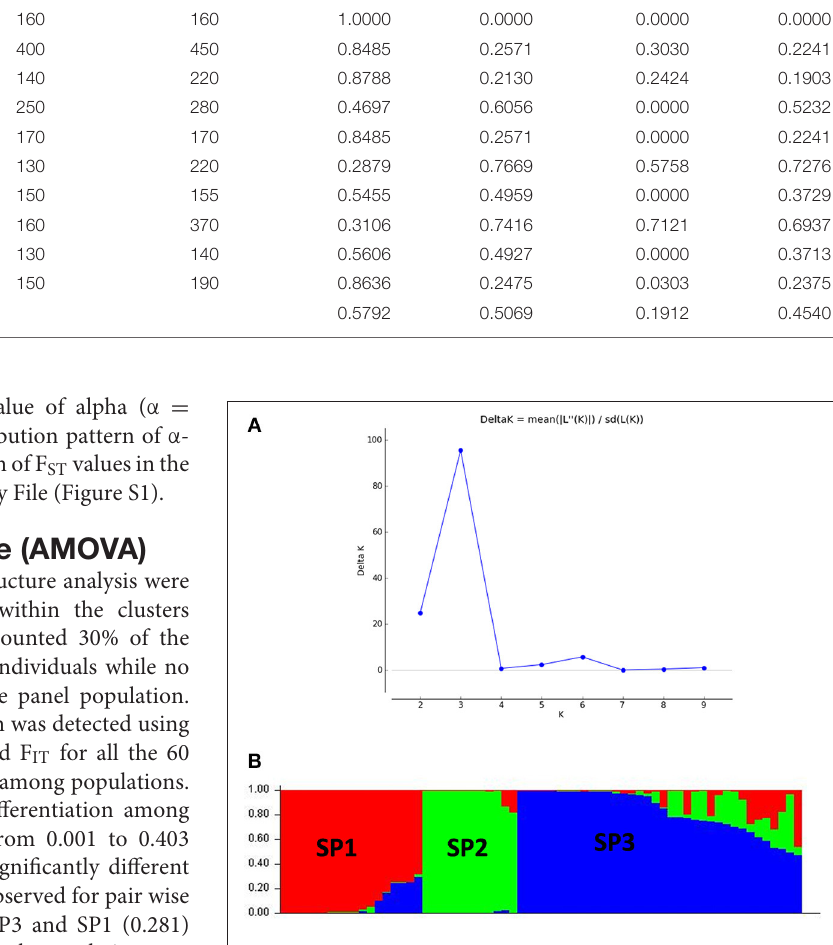
FIGURE 5 | (A) Graph of estimated membership probability fraction for K = 3. The maximum of ad-hoc measure 1 K determined by structure harvester was found to be K = 3, which suggested that the entire population can be categorized into three sub-groups (SP1, SP2, and SP3) and (B) population structure of a panel possessing 66 genotypes based inferred ancestry using 60 molecular markers ( K =